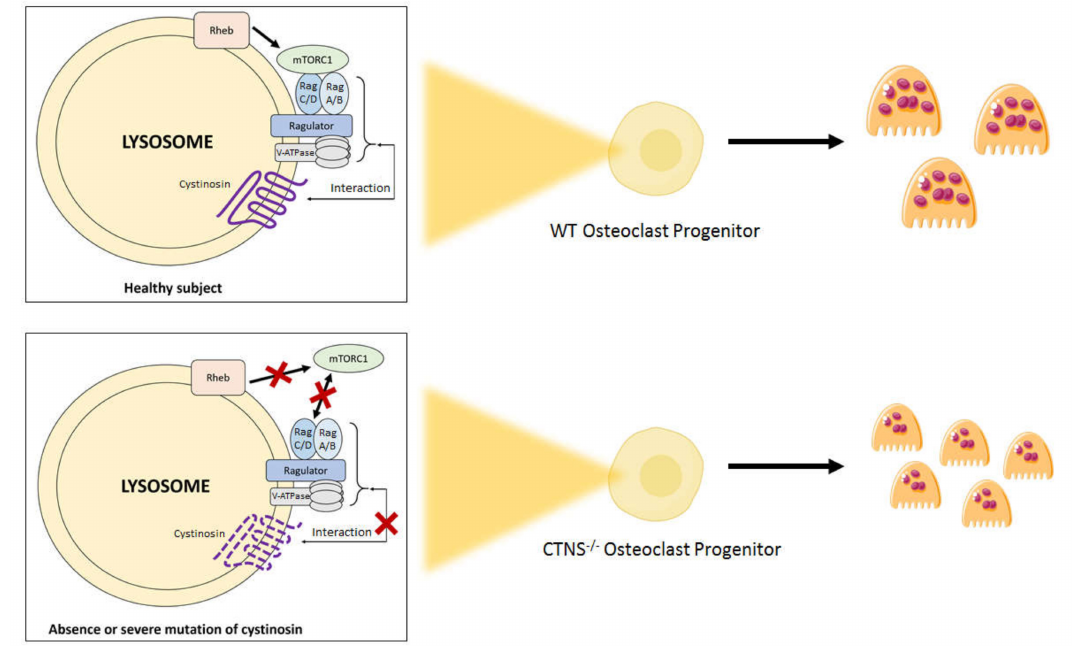
Figure 2. Hypothetical regulation of mtorc1 activation in osteoclasts derived from healthy donors and from patients with nephropathic cystinosis. The Ragulator-Rag Complex has a key role in mTOR signaling regulation. The Ragulator, along with the Rag GTPases, are necessary for the localization of mTORC1 to the lysosome surface. When enough amino acids are present, Rag GTPases become activated, which leads to the translocation of mTORC1 from the cytoplasm to the lysosome surface. This process allows mTORC1 to bind to Rheb, which induces the kinase activity of mTORC1. Absence or severe mutation of cystinosin, a protein interacting with the Ragulator-Rag complex, might prevent the activation of mTORC1 by Rheb, which would increase the final number of osteoclasts at the end of the di ff erentiation process. mTORC1, mammalian target of rapamycine complex